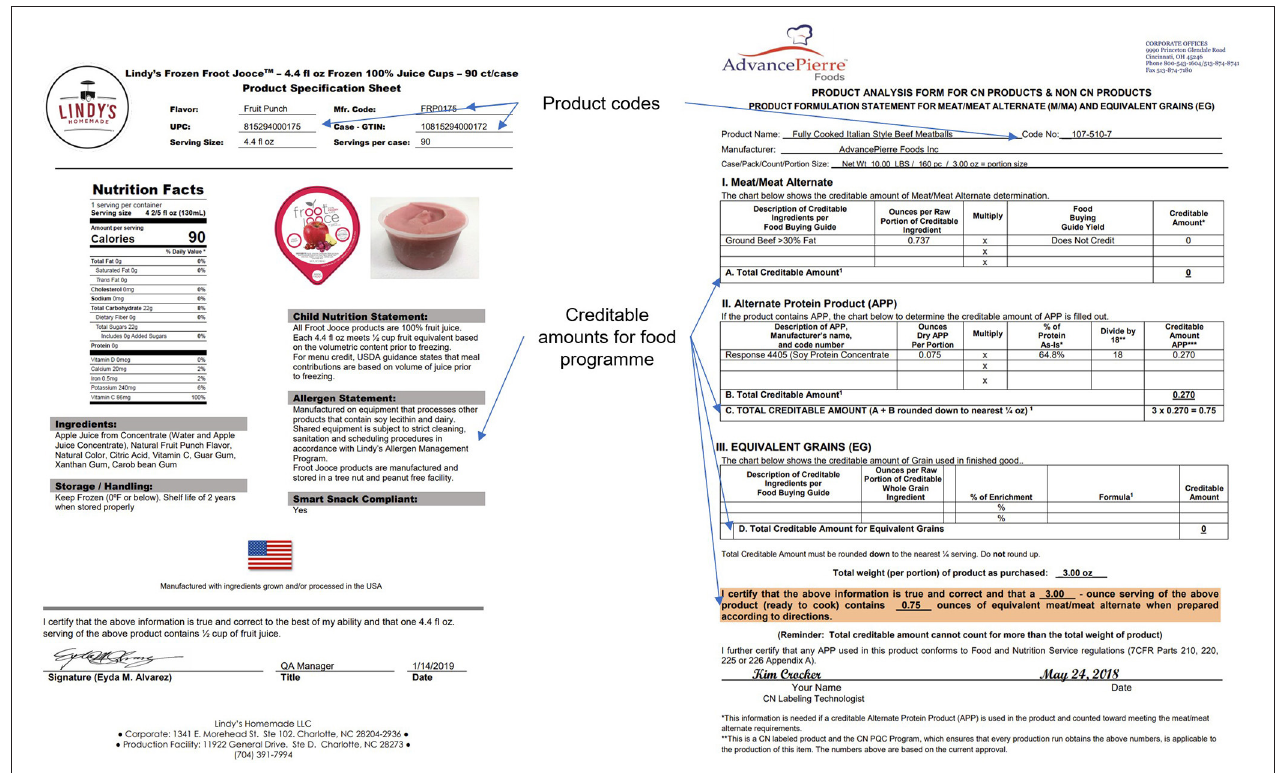
FIGURE 3 | Examples of specifications sheets variations in data fields and